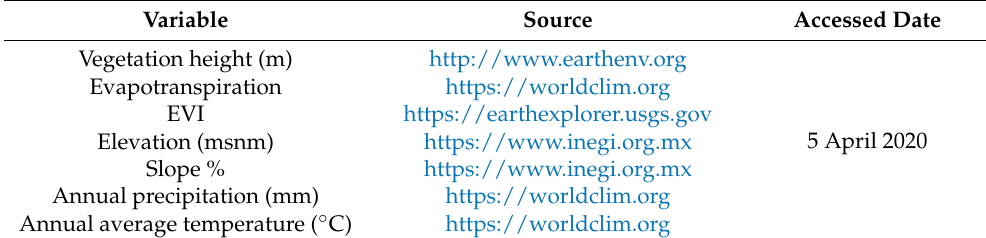
Table 2. Variables used to predict fuel load in the Tamaulipan temperate